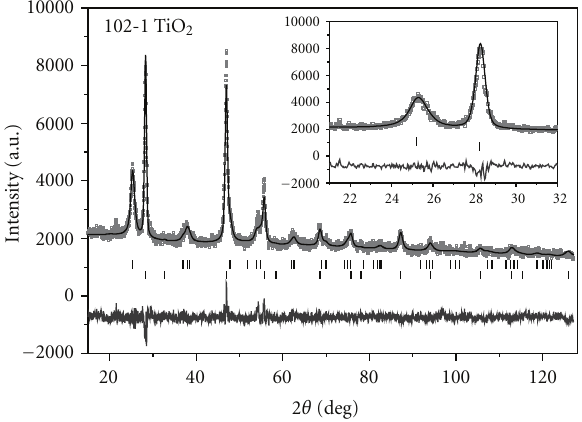
Figure 2: Rietveld refinement of a 102-1 TiO 2 /CaF 2 mixture. The vertical lines indicate Bragg positions for anatase (top) and CaF 2 (bottom), respectively. The inset shows an enlargement of the angular region 21–32 ◦ , in which the peak at 25.5 ◦ is the TiO 2 (101) peak. The R F factors are 7.0% and 6.5%, respectively, for the TiO 2 and CaF 2 phases.